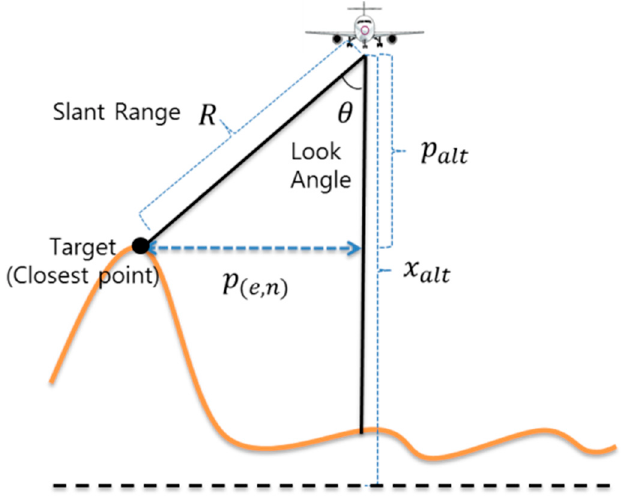
Figure 5. Measurement for TRN using IRA [8,12].